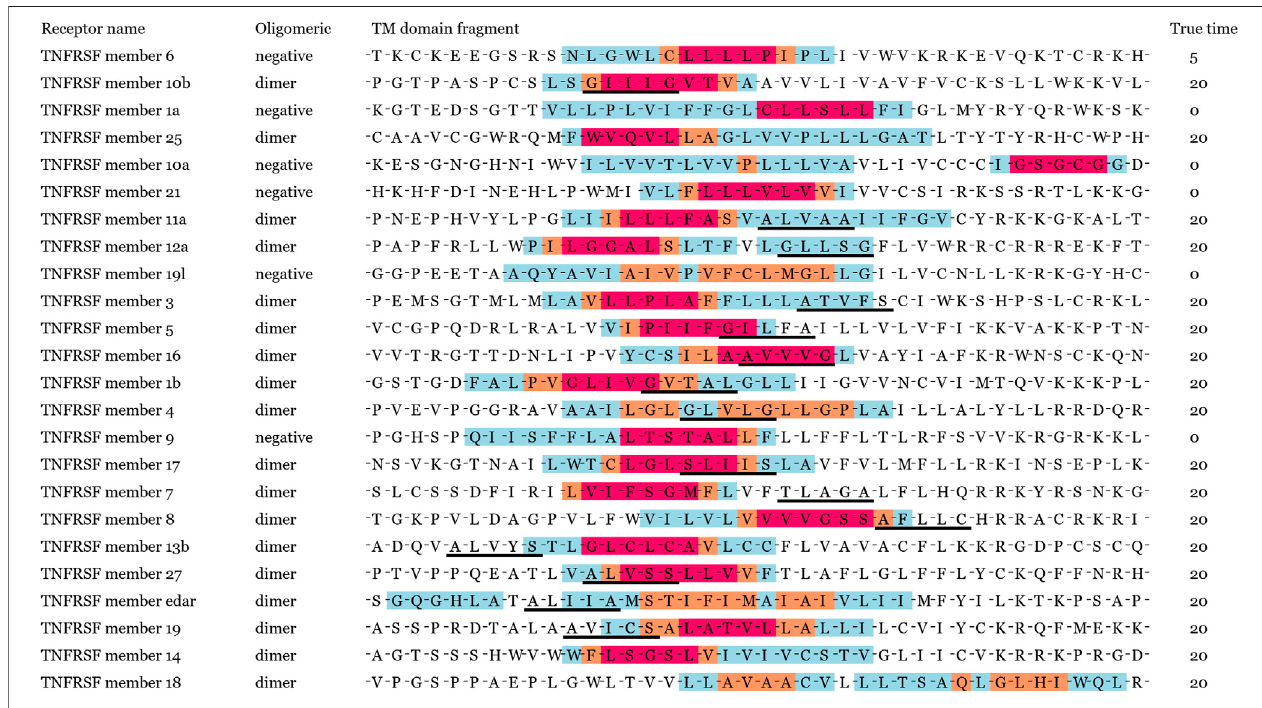
FIGURE5| Differentlevels ofpotentialmotifshasbeen predicted and labeled inred,orange andblue, respectively. Reddenotestothecoreofthepotential motifs. The speculative motifs generated by alignment of homologous species are marked by black solid line for